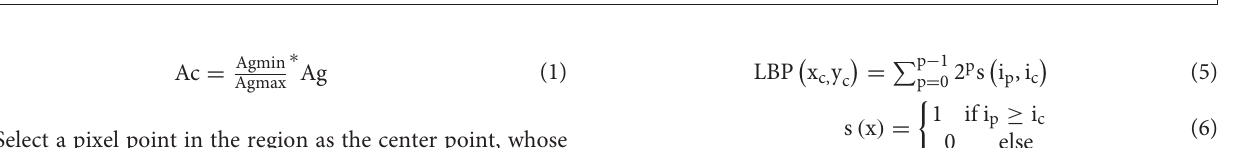
FIGURE 4 | Schematic diagram of